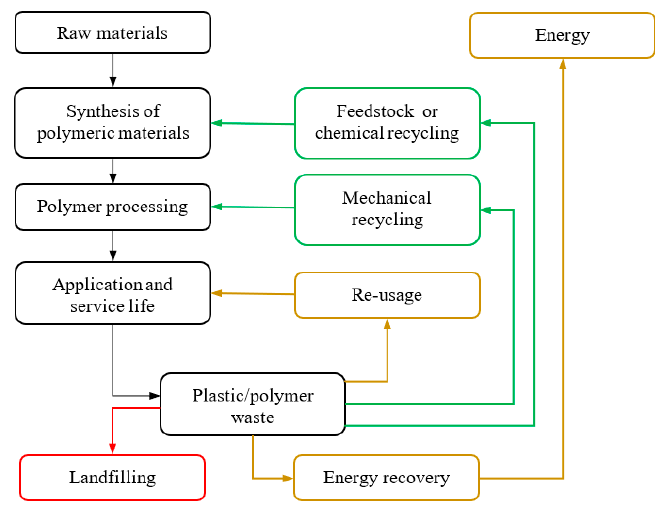
Figure 1. Representation of plastic / polymer waste management based on the work of Vilaplana and Karlsson [3]. Colors are guide of the eye regarding the desired implementation; red: undesired; brown: to be minimized; green: preferred.